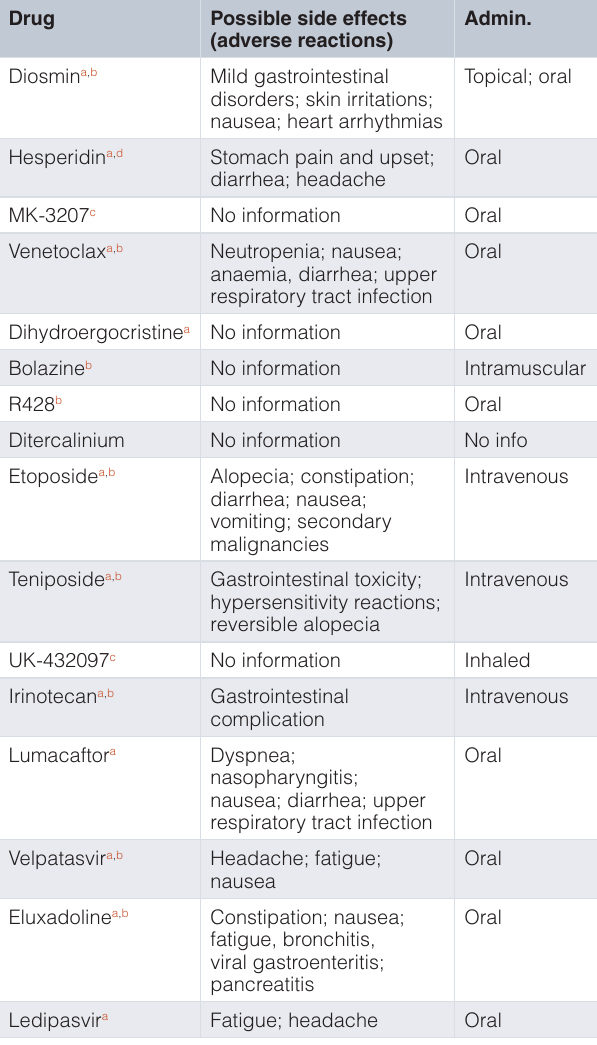
Table 4. Possible side effects and routes of administration of the drugs identified from virtual screening for SARS-CoV-2 3CL pro